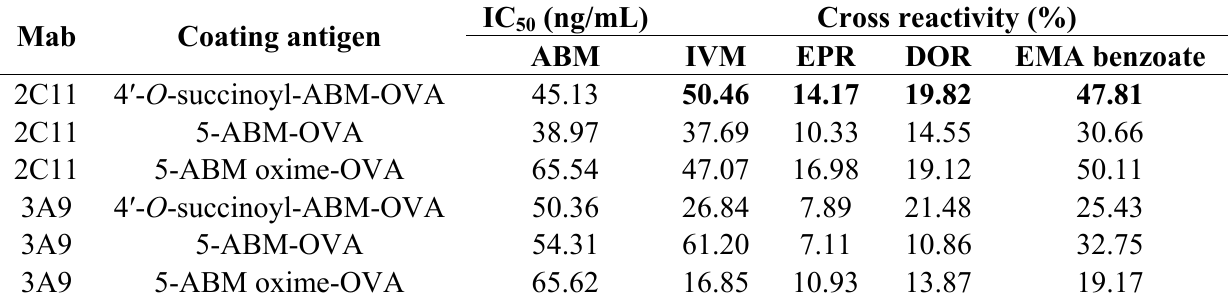
Table 2. Characterization of the selected Mabs a .